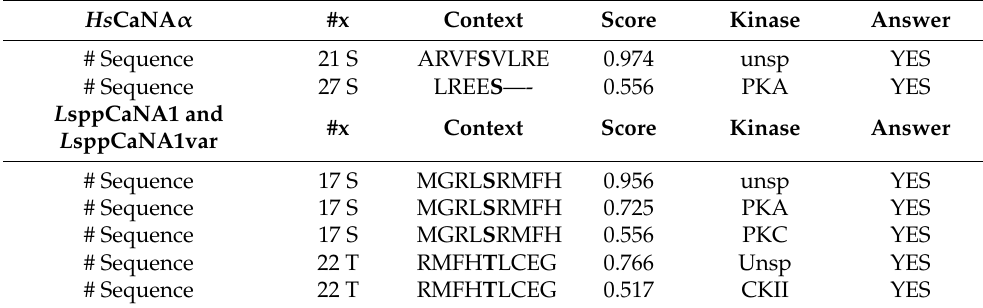
Figure 5. Phosphorylation sites of CaMB-BD in the catalytic subunits predicted by NetPhos 3.1 Server software. All phosphorylation sites presented at the different sequence positions (axis x ) are represented as the phosphorylation potential score (PPS) over the threshold at 0.5 (pink line) at the axis y . The predicted phosphorylation sites for CaM-BD in Hs CaNA α ( A ) and in L sppCaNA1 and L sppCaNA1_var ( B ). Phosphorylation sites in serine (orange) or threonine (green) are shown. Table 2. Phosphorylation prediction results of CaM-BD in